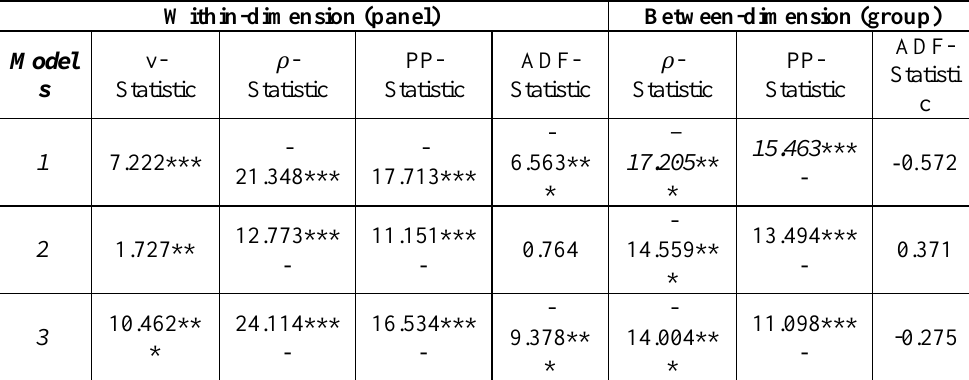
Table 4. Pedroni’s cointegration